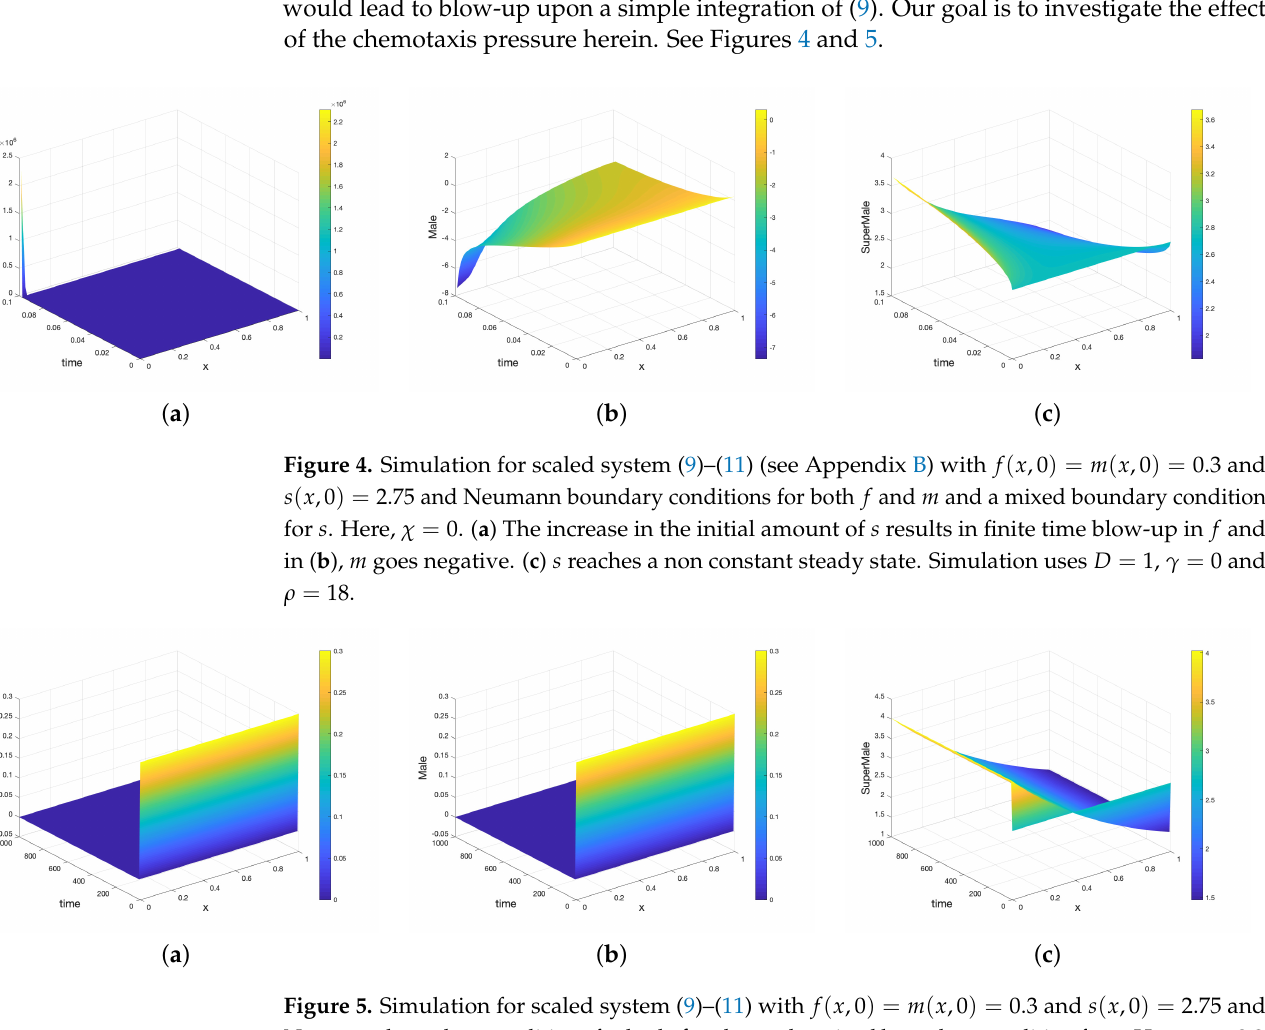
Figure 5. Simulation for scaled system (9)–(11) with f ( x ,0 ) = m ( x ,0 ) = 0.3 and s ( x ,0 ) = 2.75 and Neumann boundary conditions for both f and m and a mixed boundary condition for s . Here, χ = 2.2. ( a ) Finite time blow-up in f is damped and f goes to 0. ( b ) m goes to 0. ( c ) s reaches a non constant steady state. Simulation uses D = 1, γ = 0 and ρ =